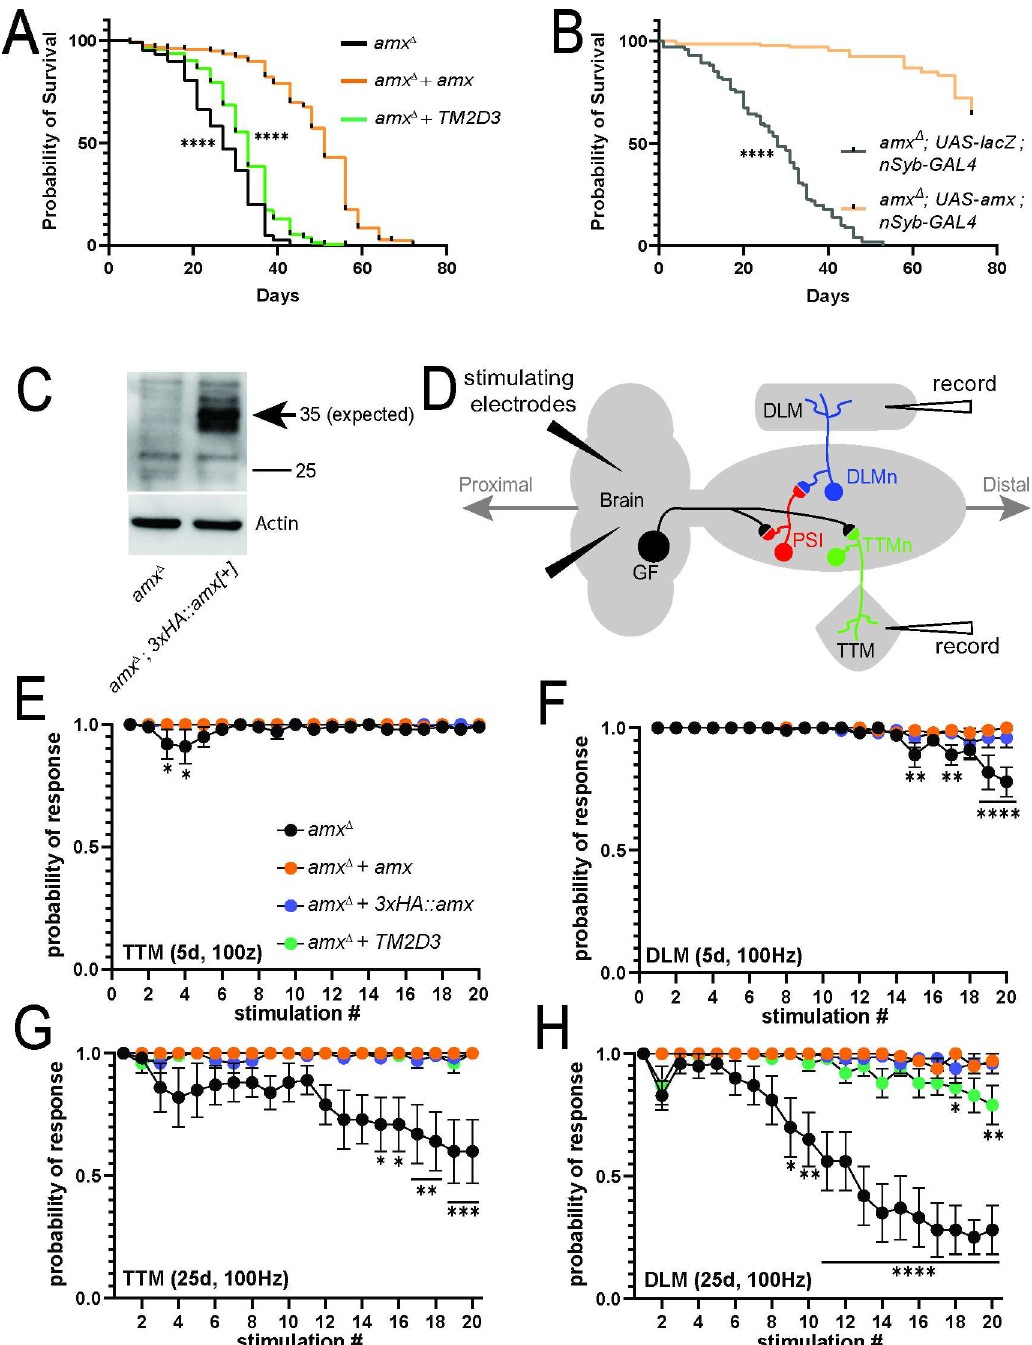
Fig 6. Loss of amx causes shortening of lifespan and age-dependent neurophysiological defects. (A) Lifespan assay shows amx Δ animals (black, n = 247) have reduced lifespan compared to amx Δ + amx controls (orange, n = 224). amx Δ + human TM2D3 flies (green, n = 234) have significantly longer lifespan than amx Δ animals, but shorter than control. Animals were reared at 25˚C; Log-rank test (Mantel-Cox), ���� = p < 0.0001. (B) Restoring Amx expression specifically in neuronal cells rescues the reduced lifespan in amx null animals. LacZ overexpression was used as a control. Animals were reared at 25˚C; Log-rank test (Mantel-Cox), ���� = p < 0.0001. (C) Western blot of amx Δ ; 3xHA :: amx brains shows that 3xHA::Amx (predicted 35 kDa size) is expressed in the adult nervous system (arrow). Protein isolate from five brains was loaded per lane and Actin was probed as a loading control. (D) Schematization of the giant fiber electrophysiological recordings. Stimulating electrodes are inserted into the brain and recording electrodes record responses from the TTM and DLM muscles. (E-F) TTM muscles of 5d old amx Δ mutants